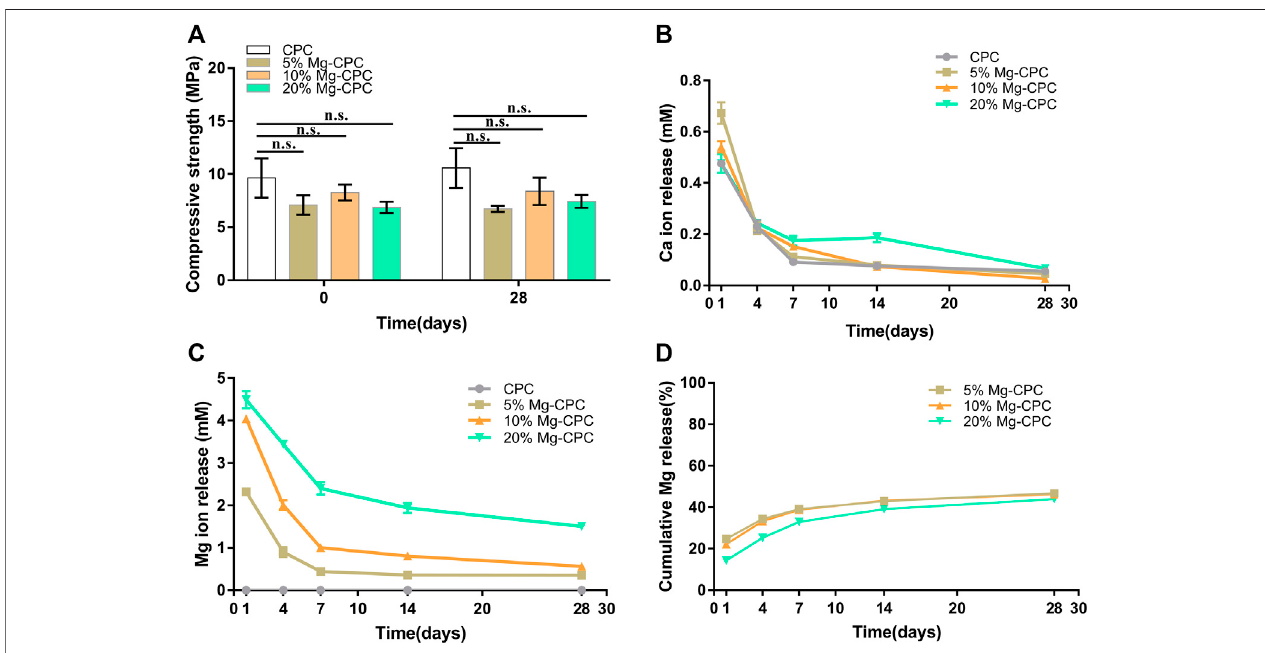
FIGURE 3 | Material characterization of bone cement in vitro . (A) Compressive strength of CPC and Mg-CPCs samples after immersion in SBF at day 0 and 28 (n.s., no signi fi cant difference). (B) Ca released into PBS determined by ICP-MS. (C) Mg released into PBS determined by ICP-MS. (D) Cumulative release of Mg.